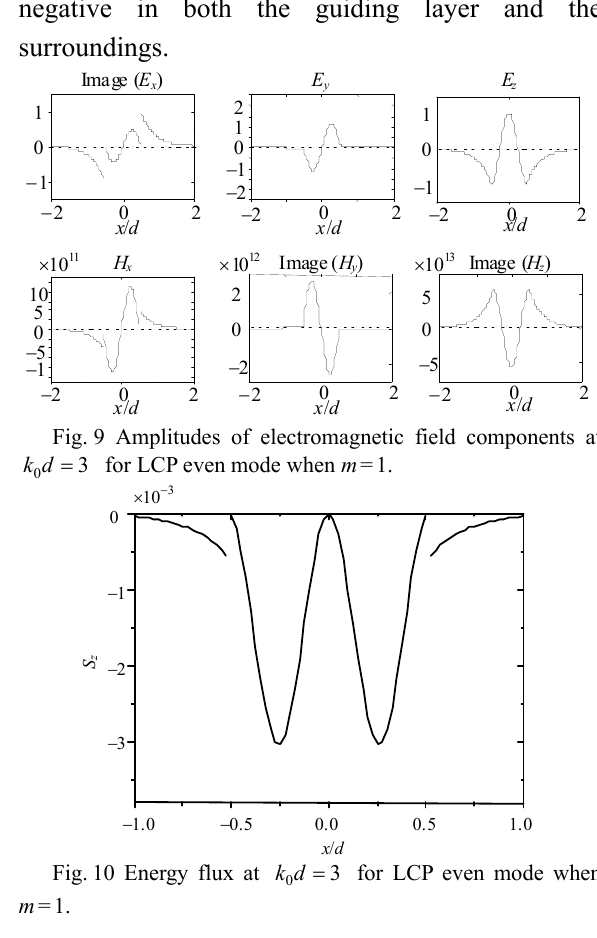
Fig. 7 Field profiles at fundamental mode.